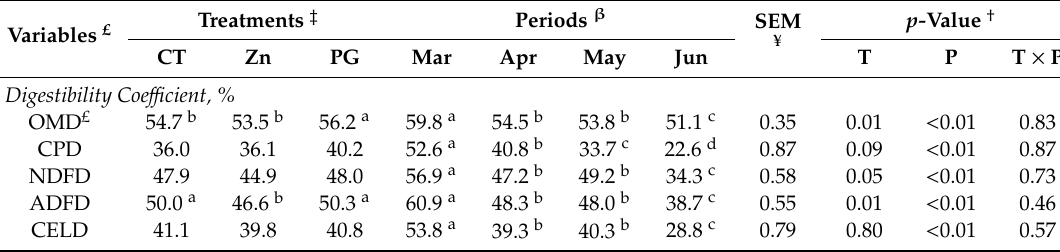
Table 6. E ff ects of zinc sulfate or propylene glycol supplementation on nutrient digestibility in sheep on Caatinga -native